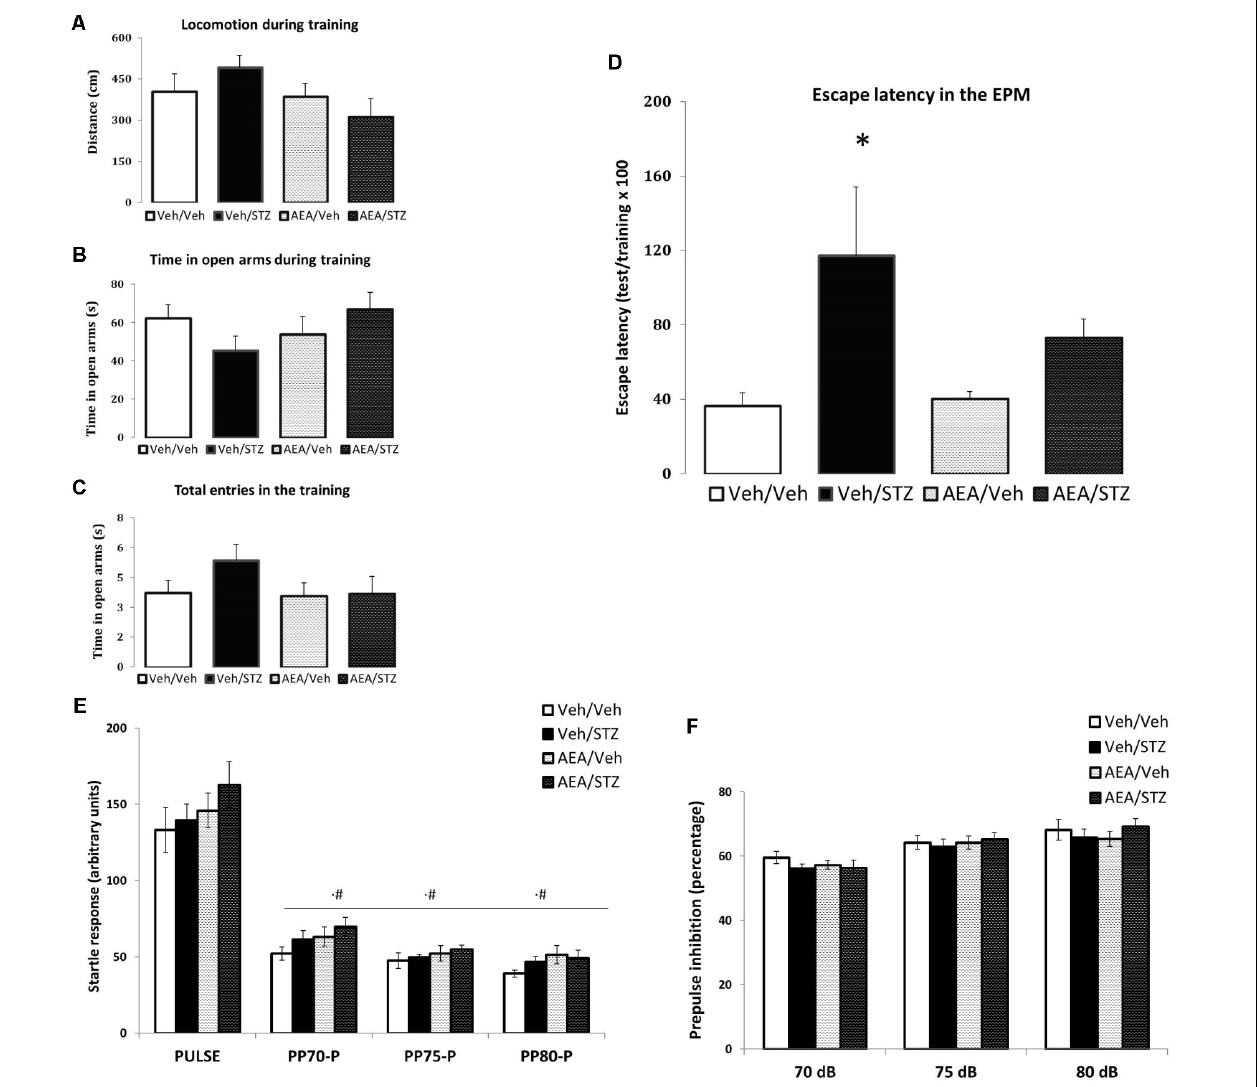
FIGURE 3 | Performance of Wistar rats icv-treated with AEA and/or STZ (Veh/Veh, Veh/STZ, AEA/Veh, and AEA/STZ) in anxiety (A–C) and memory (D) parameters in the escape latency test in the EPM 30 days after treatment and in startle (E) and prepulse inhibition responses (F) . (A) Distance (in cm), (B) time spent in open arms and (C) the number of total entries during the training session, represented as means ± S.E.M. ( n = 56 animals per group). No differences were detected between groups (one-way ANOVA). (D) Percentage of the time needed to enter in one closed arm in the test session compared to training, represented as means ± S.E.M. ( n = 11–12 animals per group. ∗ p < 0.05, Veh/STZ is different from Veh/Veh (repeated measures ANOVA, followed by Duncan’s post-test). (E) Startle response after a tone stimulus of 120 dB (pulse) preceded or not by a tone stimulus of 70, 75, or 80 dB (prepulse) presented in a pseudorandomic manner, represented as means ± S.E.M. ( n = 7–10 animals per group). # p ≤ 0.05, ASR response with pulse preceded prepulse of 70, 75, and 80 dB was lower than pulse alone (repeated measures ANOVA, followed by Duncan’s post-test). (F) Percentage of inhibition of startle response caused by the prepulse + pulse (prepulse inhibition)